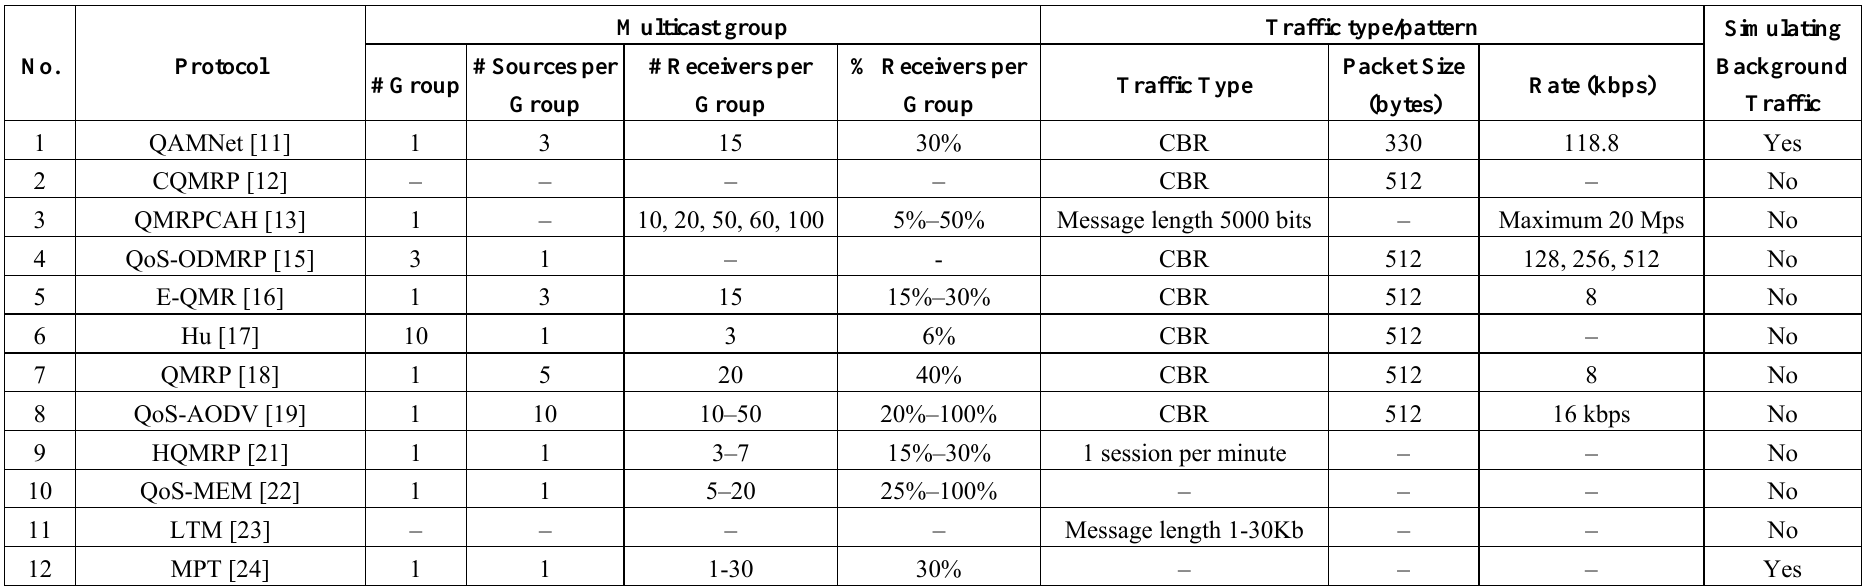
Table 4. Simulation parameters of evaluated scenarios